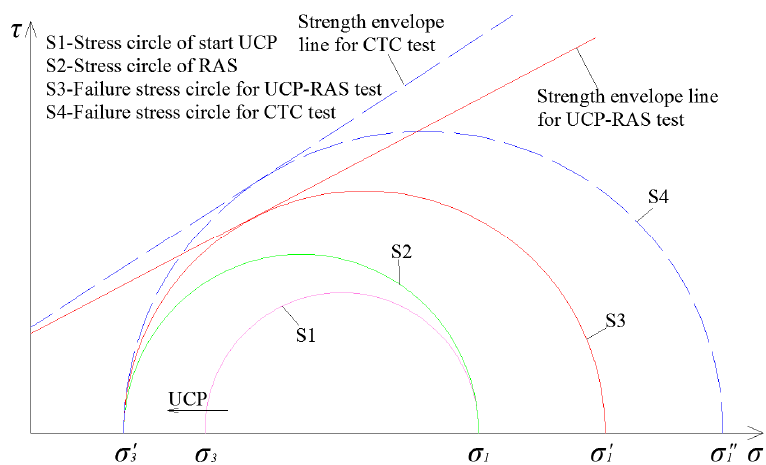
Figure 16. Mohr’s circles of coal in Stress Paths II and III.